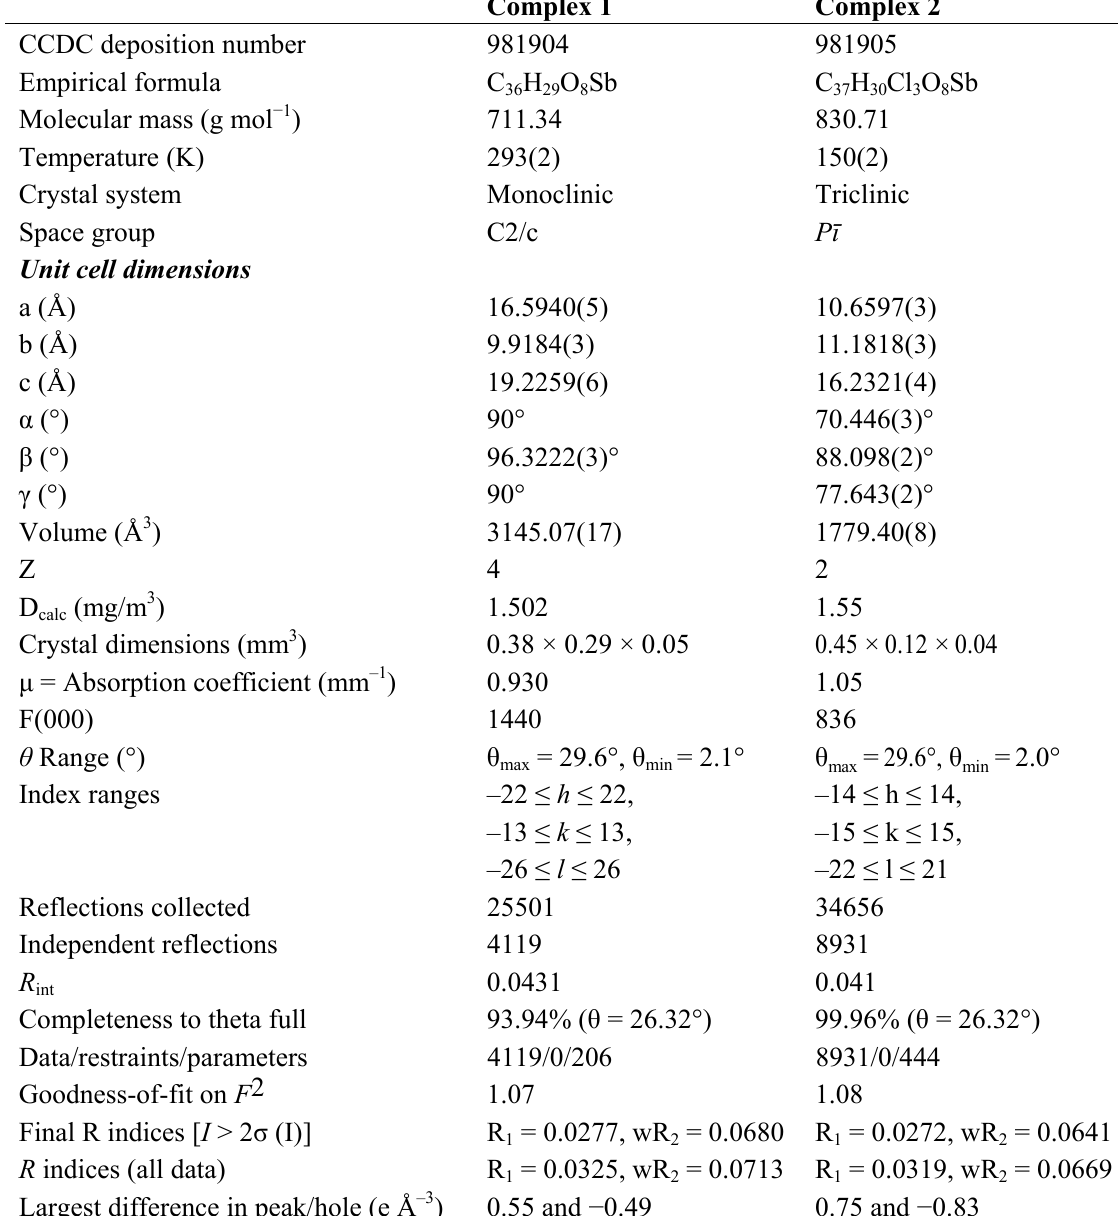
Table 1. Crystallographic data and structural refinement parameters for complexes 1 and 2